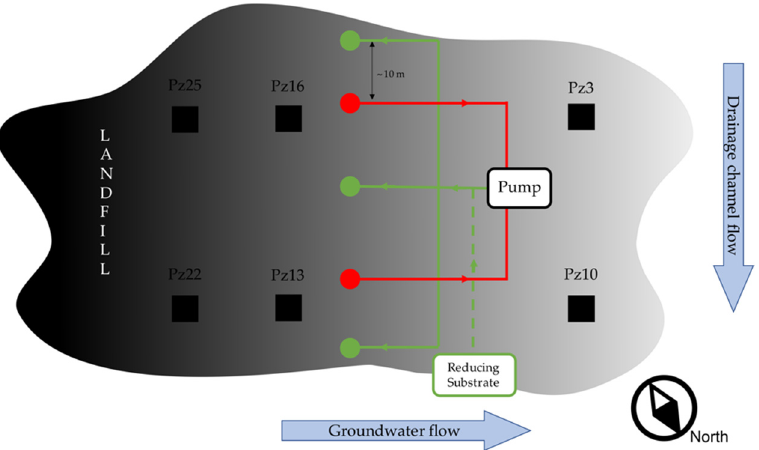
Figure 1. Position of the monitoring piezometers near the permeable reactive bio-barrier. Red lines indicate the extraction wells, whereas green lines indicate the injection wells.